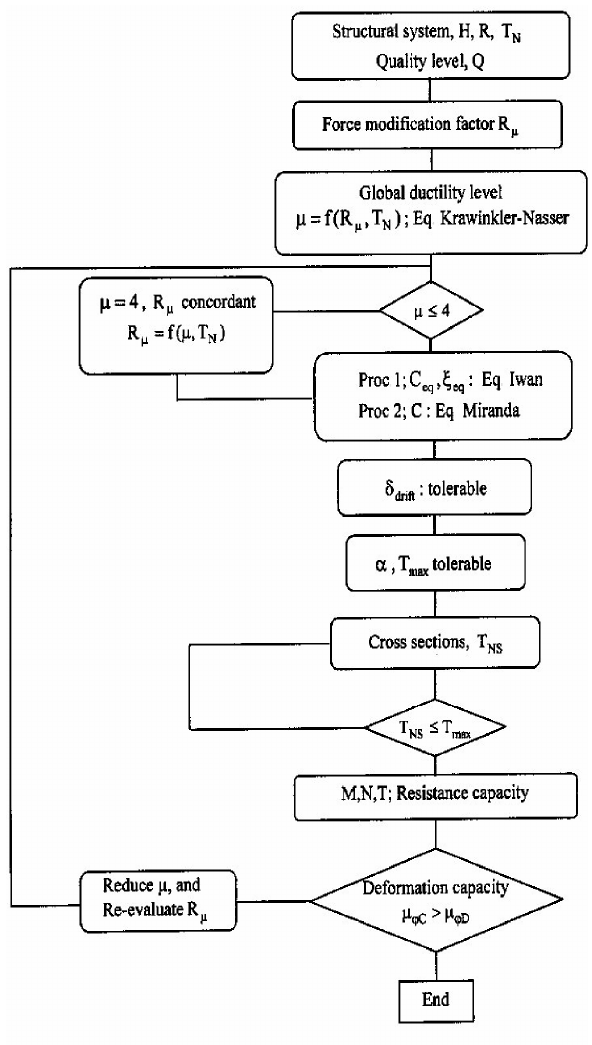
Fig 1. Design procedure for two performance